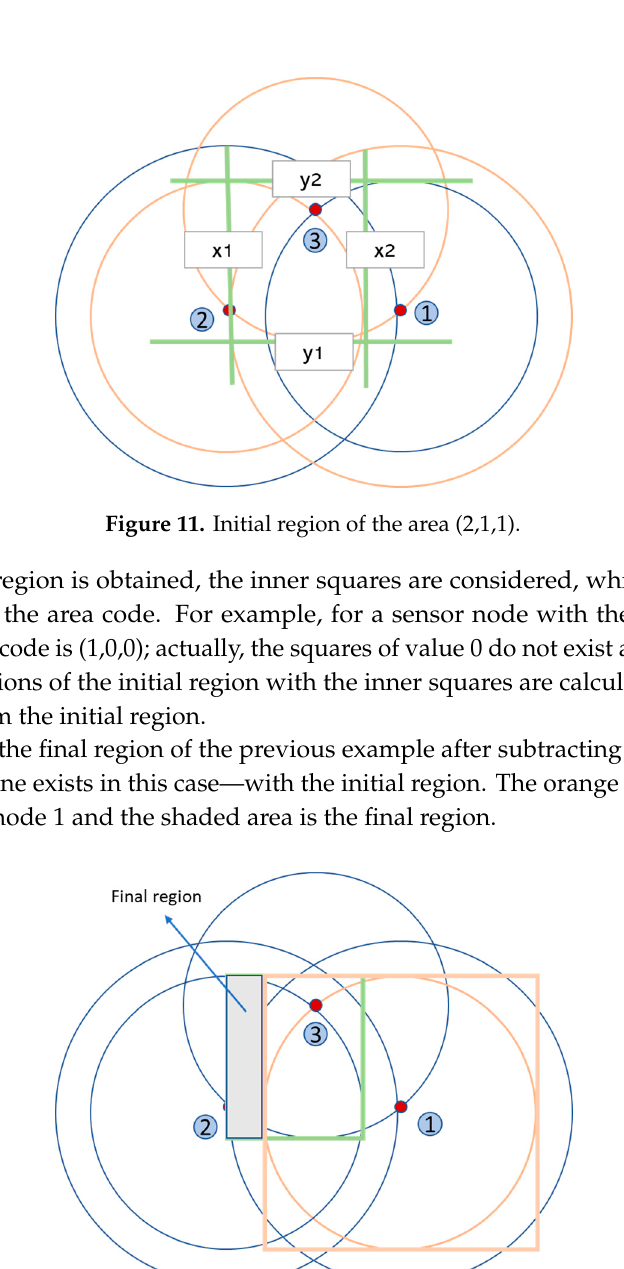
Figure 10. Restrictive limits of the area (2,1,1).